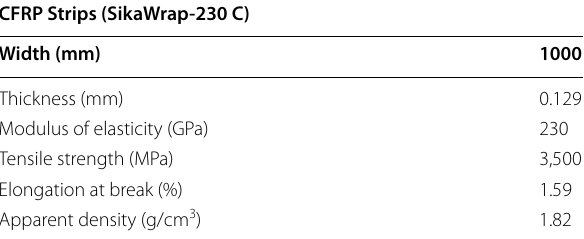
Table 2 Properties of the CFRP SikaWrap‑230 C.